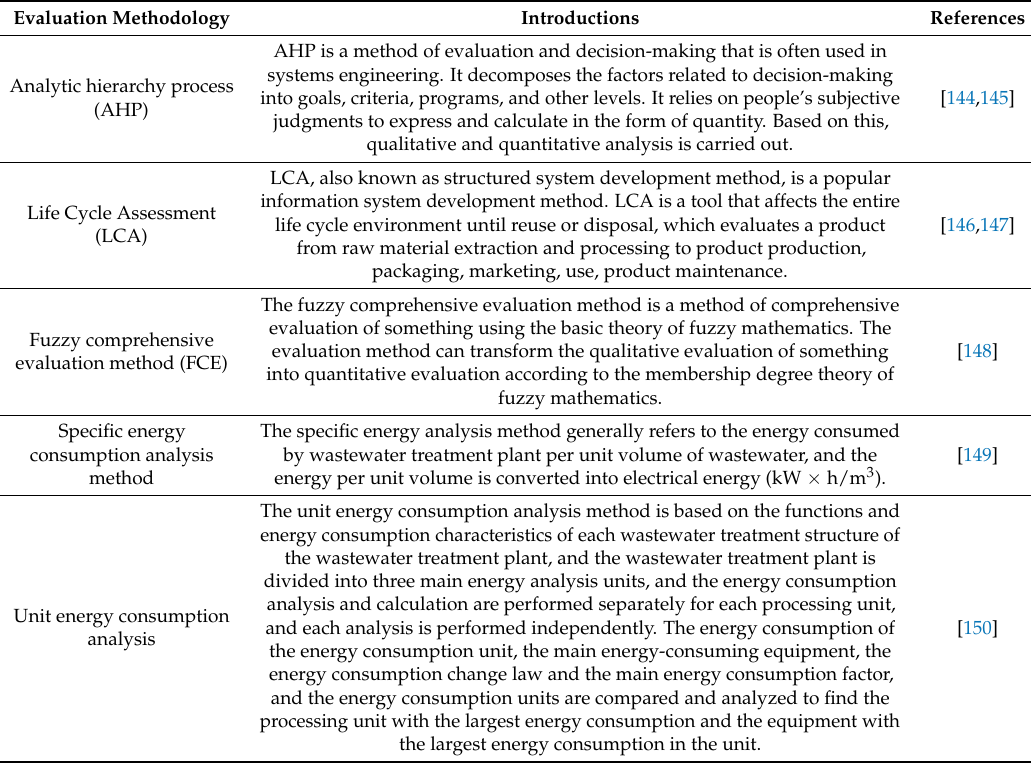
Table 2. Assessment methods for energy conservation in wastewater treatment